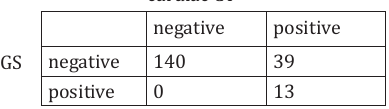
Sensitivity, specificity, positive and negative predictive values of cardiac CT: 2012–2015